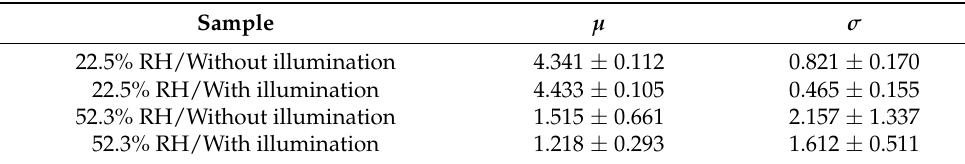
Table 3. Values of the model parameters ( µ and σ ) for each storage condition using a Weibull distribution for survival analysis.